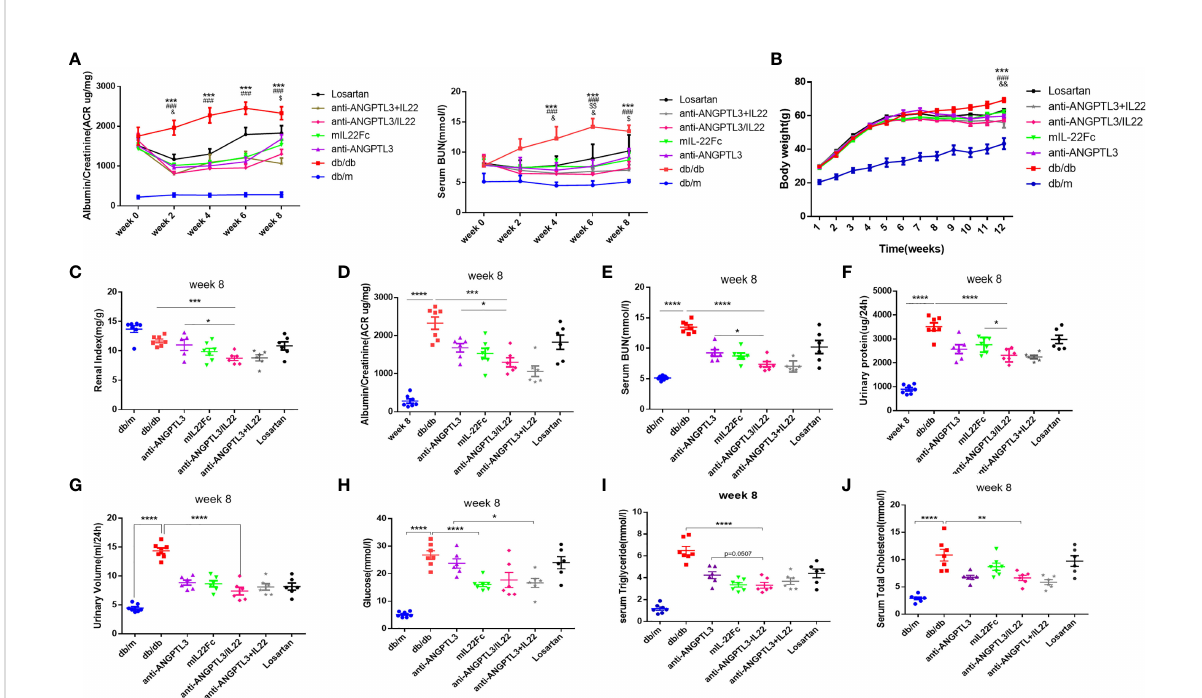
FIGURE 3 Ef fi cacy in improving renal function of anti-ANGPTL3/IL22 fusion protein in DN mice. (A) The tendency of ACR and serum BUN during eight weeks of drug administration. (B) Quantitative analysis of body weight trends. * and # respectively represent the Student ’ s t-test of db/db group and anti-ANGPTL3/IL22 treatment compared with db/m group at twelve week. $ and & respectively represent the Student ’ s t-test of anti- ANGPTL3 and mIL22Fc treatment compared with anti-ANGPTL3/IL22 group. (C) Renal index (kidney weight/body weight) was measured to reveal the degree of kidney injury. (D-G) Trends of ACR, serum BUN, 24-hour urine volume and urine protein in db/db mice after 8 weeks of treatment with anti-ANGPTL3/IL22. (H-J) Measurements of blood glucose, serum triglyceride and serum T-CHO after the 8 weeks of anti-ANGPTL3/IL22 administration. * P < 0.05; ** P < 0.01; *** P < 0.001; **** P < 0.0001. & P < 0.05; && P < 0.01. $ P < 0.05; $$ P < 0.01.### P <